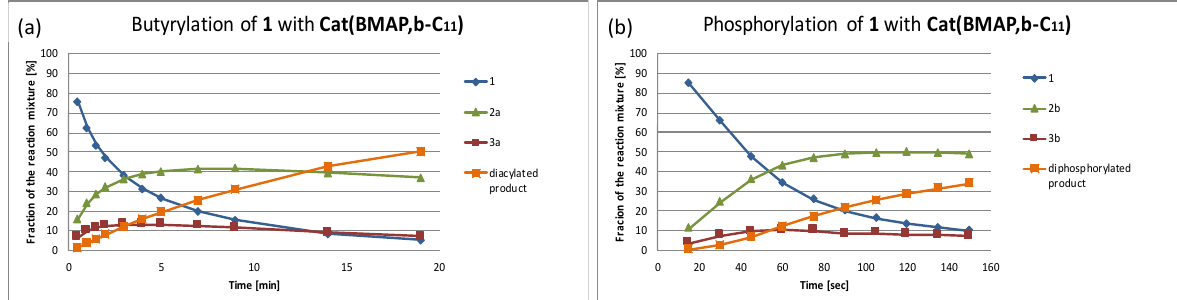
Table 3. Butyrylation and phosphorylation of substrate 1 , promoted by the catalysts of the Im fam- ily, as depicted in Scheme 3.